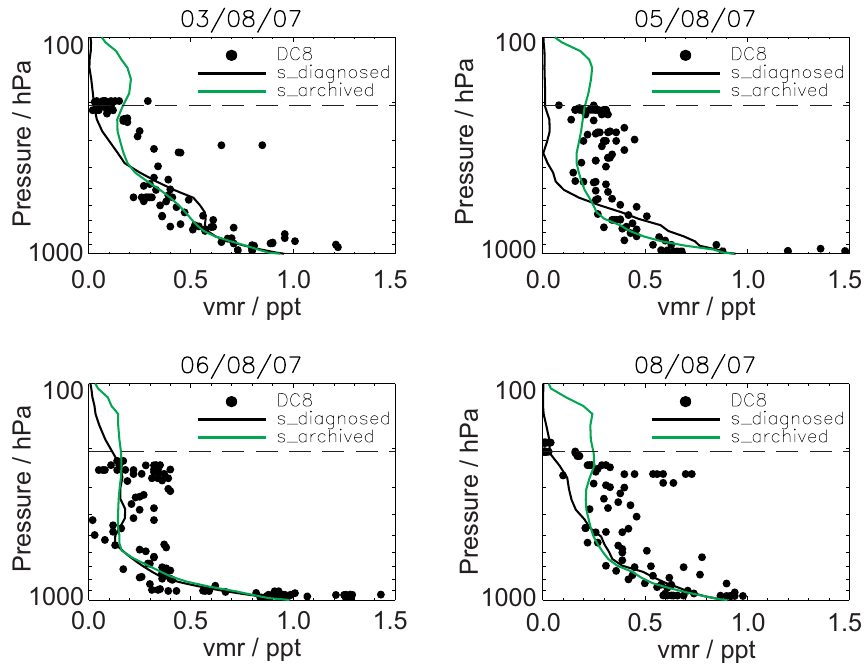
Fig. 2. Comparison of modelled CH 3 I profiles with observations made on board 4 DC8 flights during the NASA TC4 campaign (July–August 2007, http://www.espo.nasa.gov/tc4/). The CTM profiles are from both runs S diagnosed and S archived . The approximate base of the TTL is indicated with a dashed line.